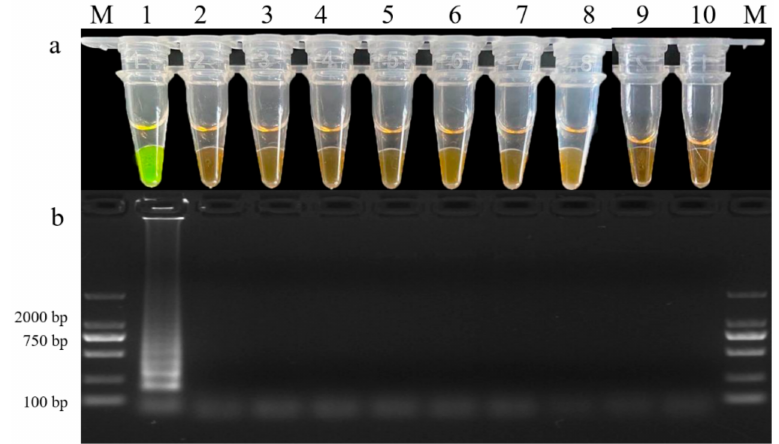
Figure 8. Specificity of loop-mediated isothermal amplification (LAMP) on different fungal species. The LAMP products were detected based on SYBR Green I staining ( a ) and agarose gel electrophoresis ( b ). Lane M, DNA ladder; tubes and lanes 1 to 10, LAMP products with genomic DNA of P. graminea isolate P.g-1, P. avena isolate P.a-1, U. hordei isolate U.h-1, U. nuda isolate U.n-1, D. graminicola isolate D.g-1, A. alternata isolate A.a-1, F. graminearum isolate F.g-1, P. oryzae isolate P.o-1, P. striiformis isolate P.s-1, and DNA-free ddH 2 O.